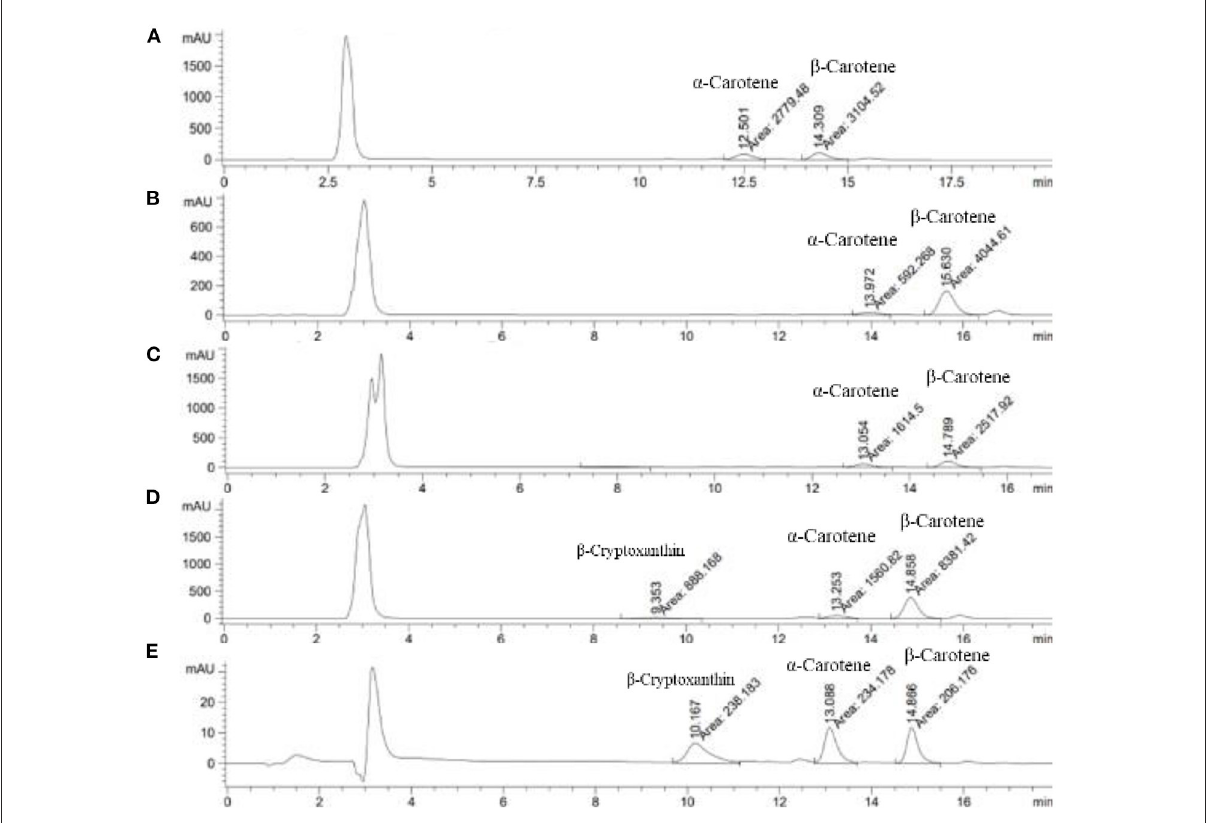
FIGURE3 Chromatogram of identifying the peaks of carotenoid compounds of Wan-Pro (A) , Ta-Kuk (B) , Som-Kob (C) , Pak-Wan-Pa (D) , Standard carotenoids (E) .